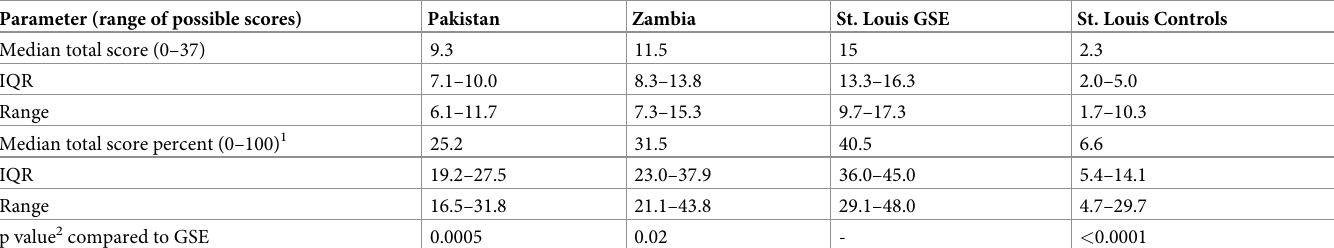
42.6%, respectively, p = 0.013). Table 5. Median total histology score and total histology score percent by